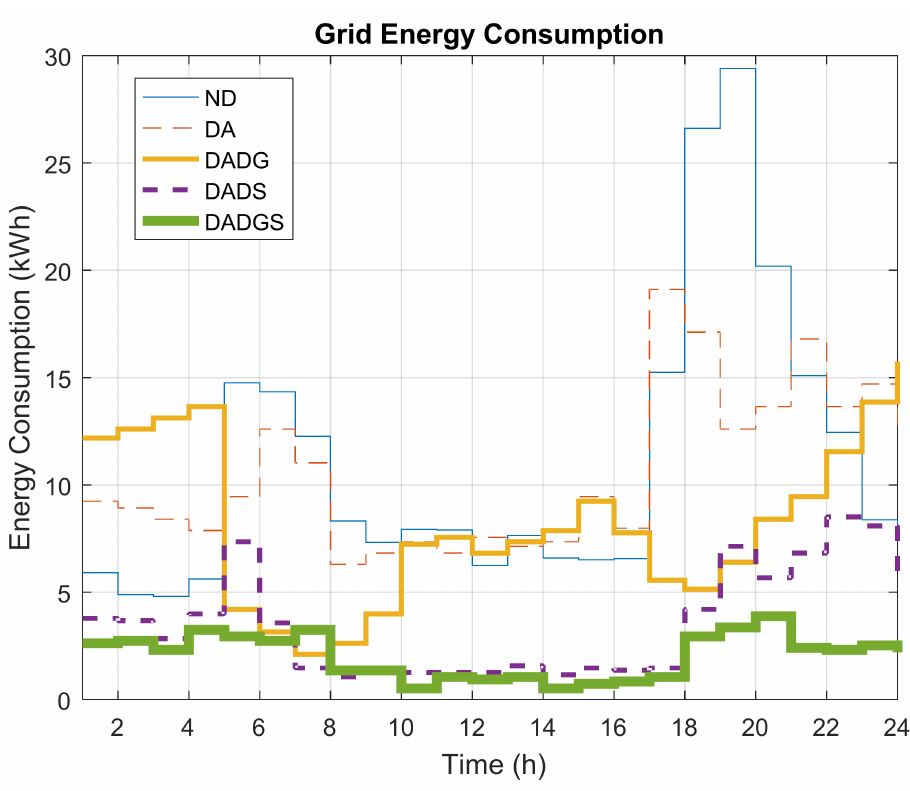
Figure 2. Hourly energy consumption from the grid.